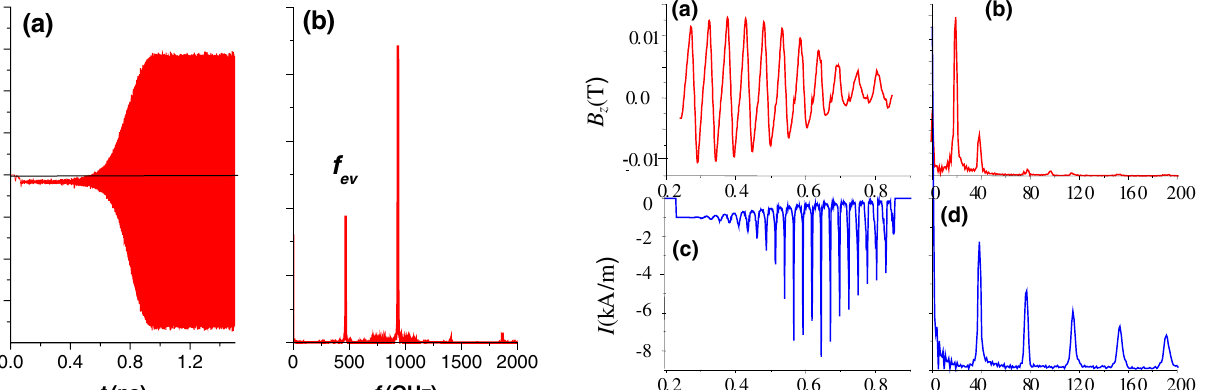
FIG. 4. (Color) Magnetic field (a) B ing FFT at a detector placed at 50 (cid:6) and 4.5 mm from the grating center